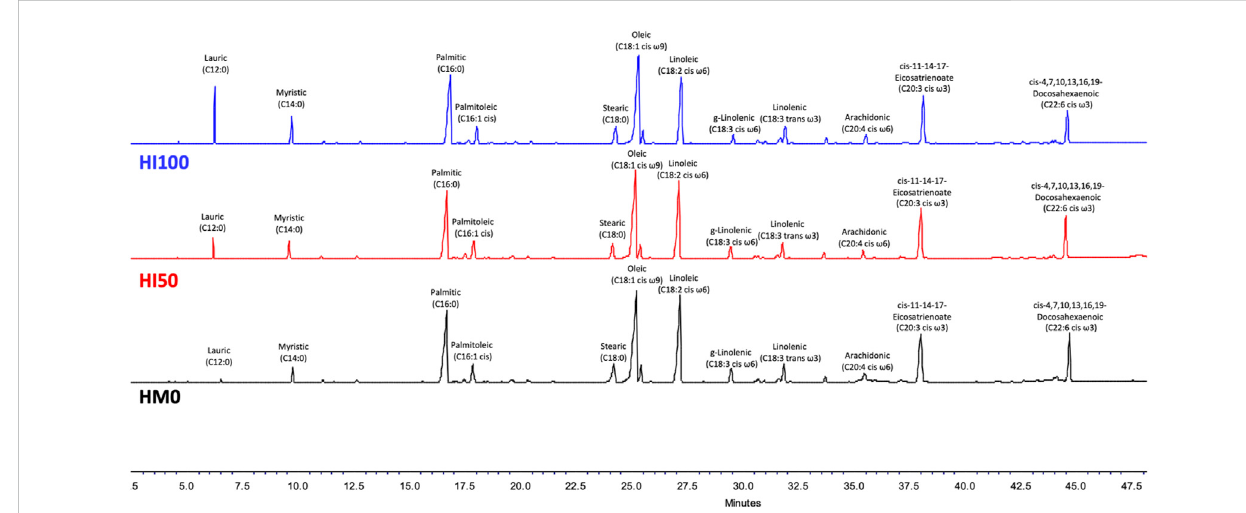
FIGURE 6 GC-FIDchromatogramsofthethreedifferentdietaryconditions.WithblackcolorisdepictedHM0(control)condition,whileredandbluecolorisfor HM50 and HM100, respectively. HM0 represents the control group while HM50 and HM100 the groups with 50% and 100% HM inclusion respectively.